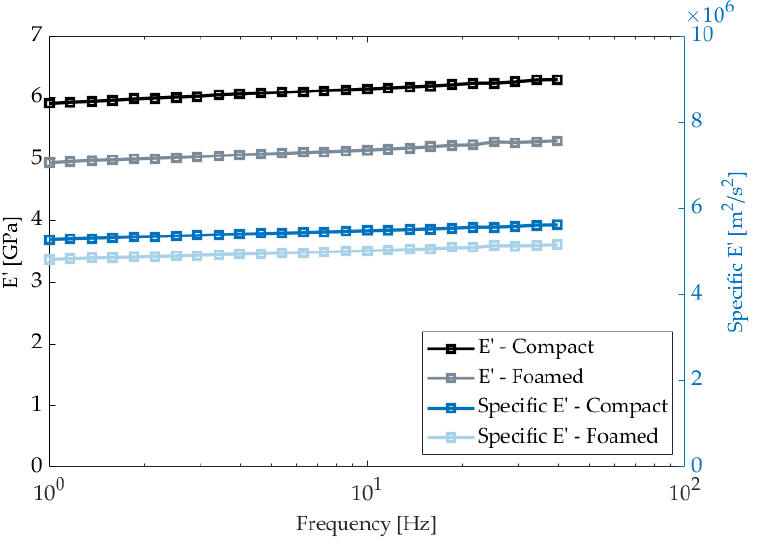
Figure 15 . Average storage moduli and specific storage moduli for compact and foamed panels. Figure 15. Average storage moduli and specific storage moduli for compact and foamed